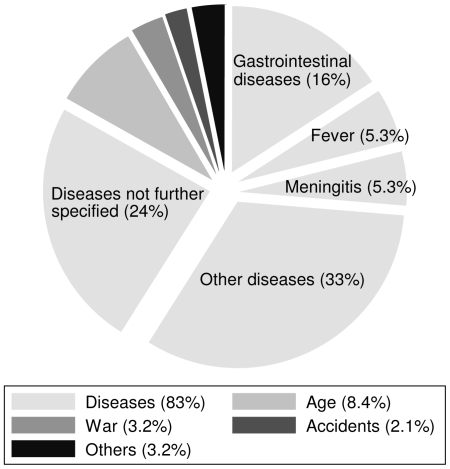
Pie chart illustrating the reported causes of death (in % of all deaths).